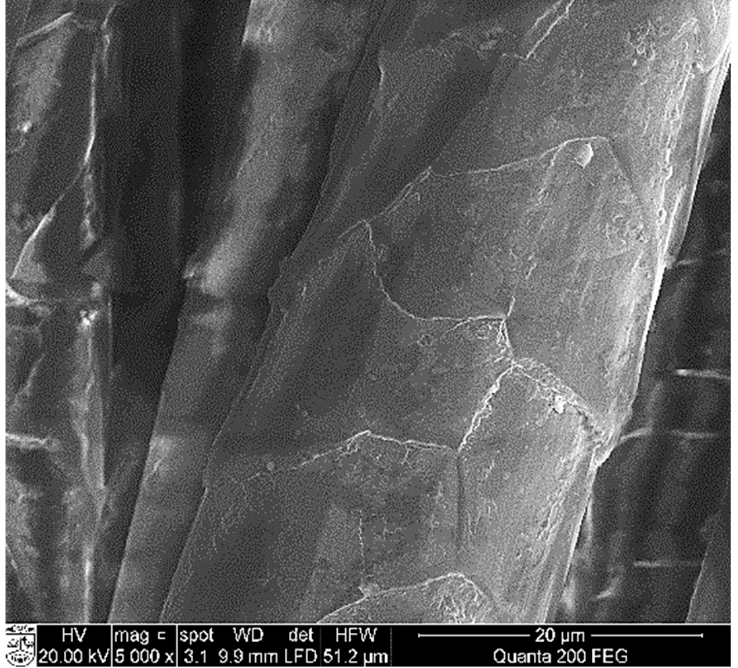
Figure 5. SEM image of wool fibers before treatment (magnification 5000 ×).